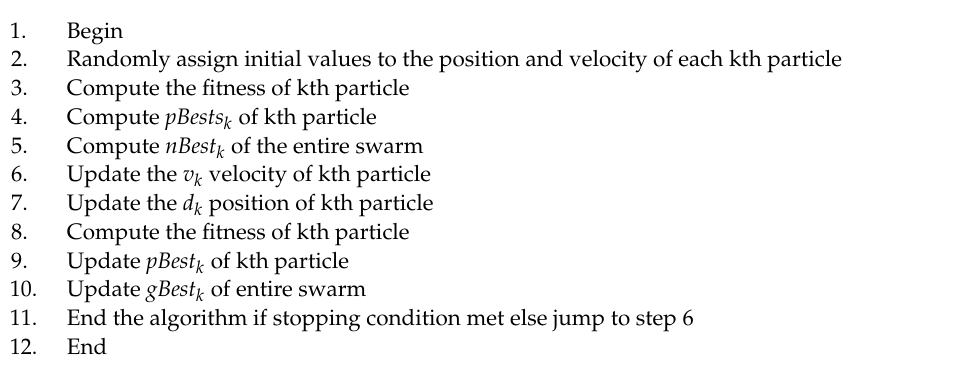
Algorithm 3: Particle Swarm Optimization Algorithm